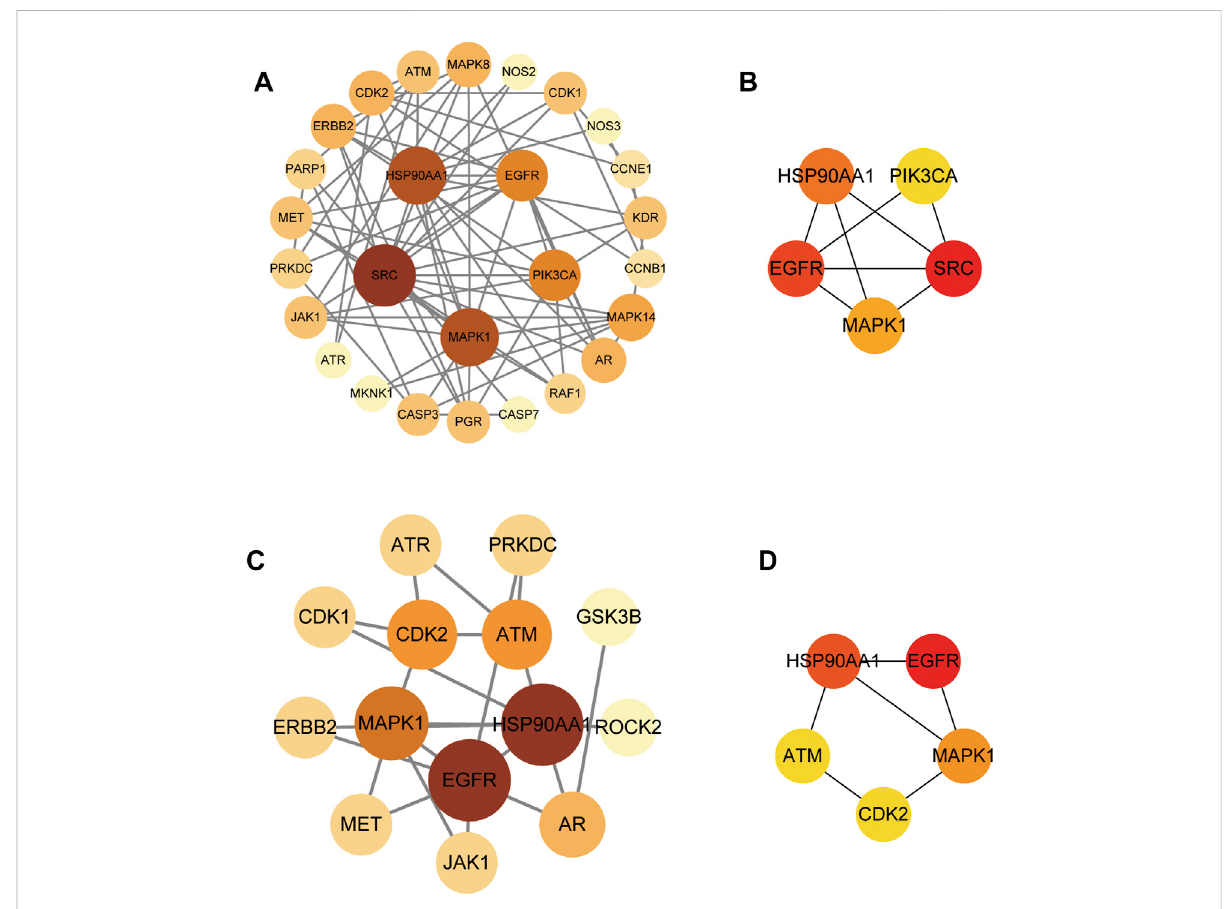
FIGURE 5 Protein – protein interaction (PPI) network and module analysis network. (A) PPI network of SchB targets on adenovirus_hepatitis presented by Cytoscape v3.8.2. (B) Module analysis of the CytoHubba plug-in identi fi ed the top fi ve genes to construct the key module network of (A) . (C) PPI network of SchB targets on SARS-CoV-2_hepatitis presented by Cytoscape v3.8.2. (D) CytoHubba identi fi ed the top fi ve genes of (C) .